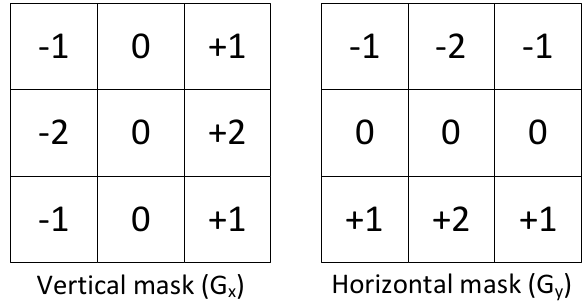
Figure 3. Sobel operator masks for detecting the edge.